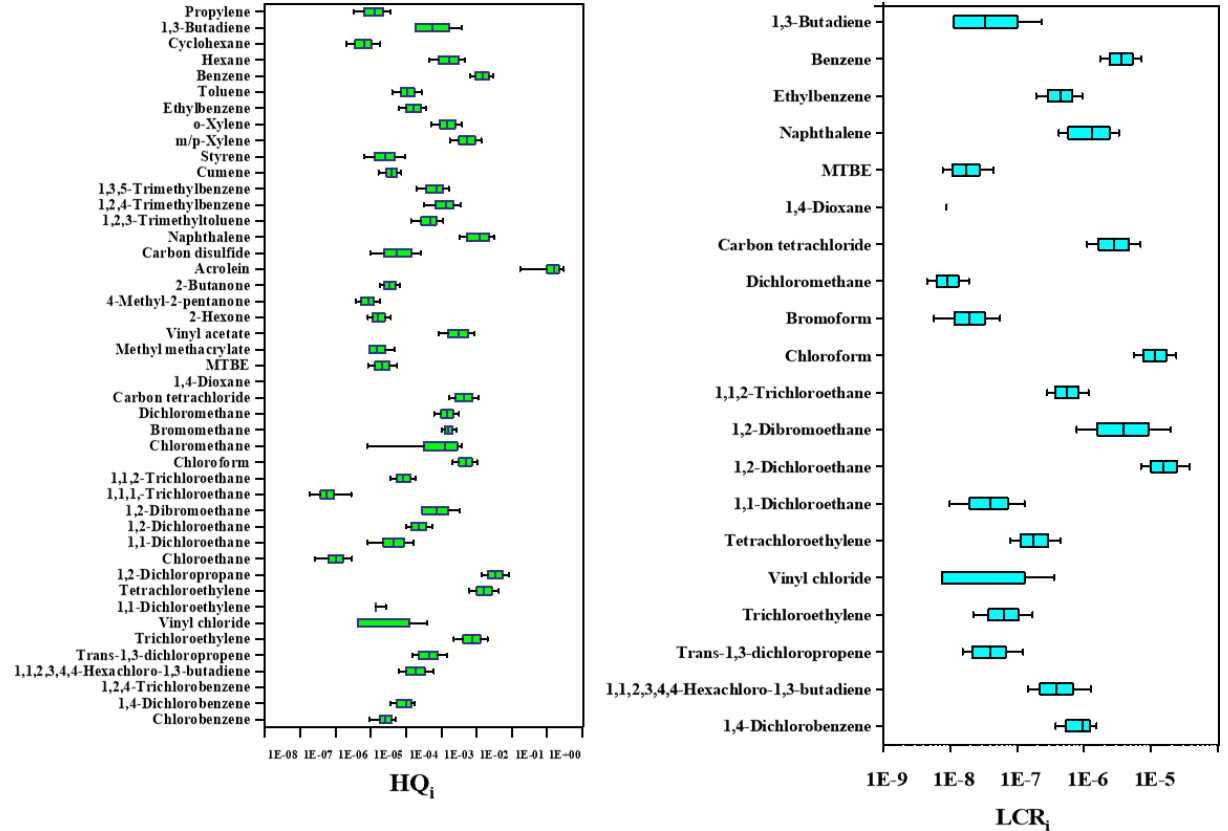
Figure 7. Non-carcinogenic risks of HQ and carcinogenic risks for individual VOC species.